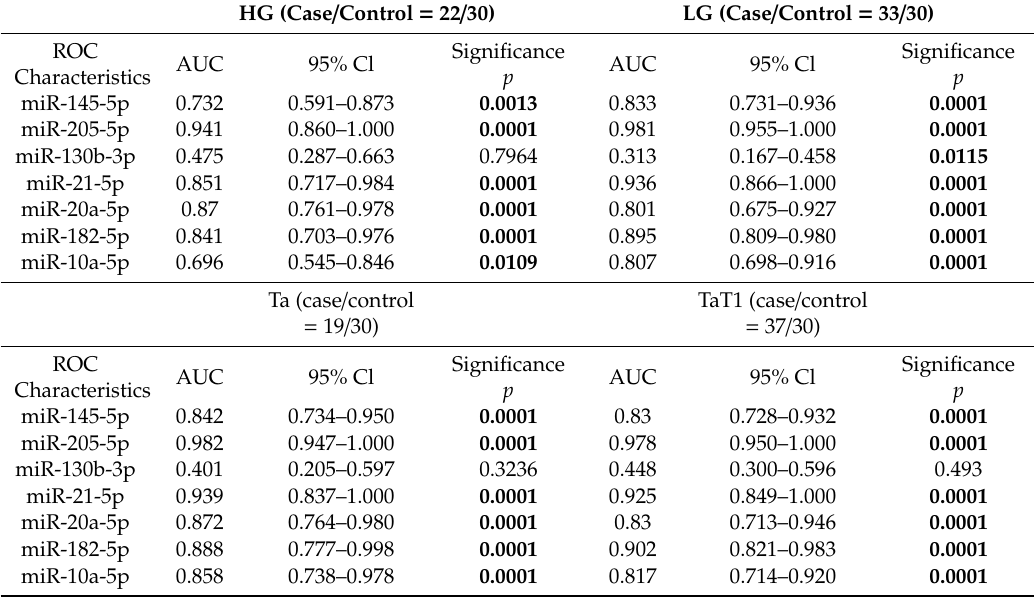
Table 6. ROC characteristics for subgroups of patients with BC (HG-high grade, LG-low grade, Ta stage, TaT1 stages) and control